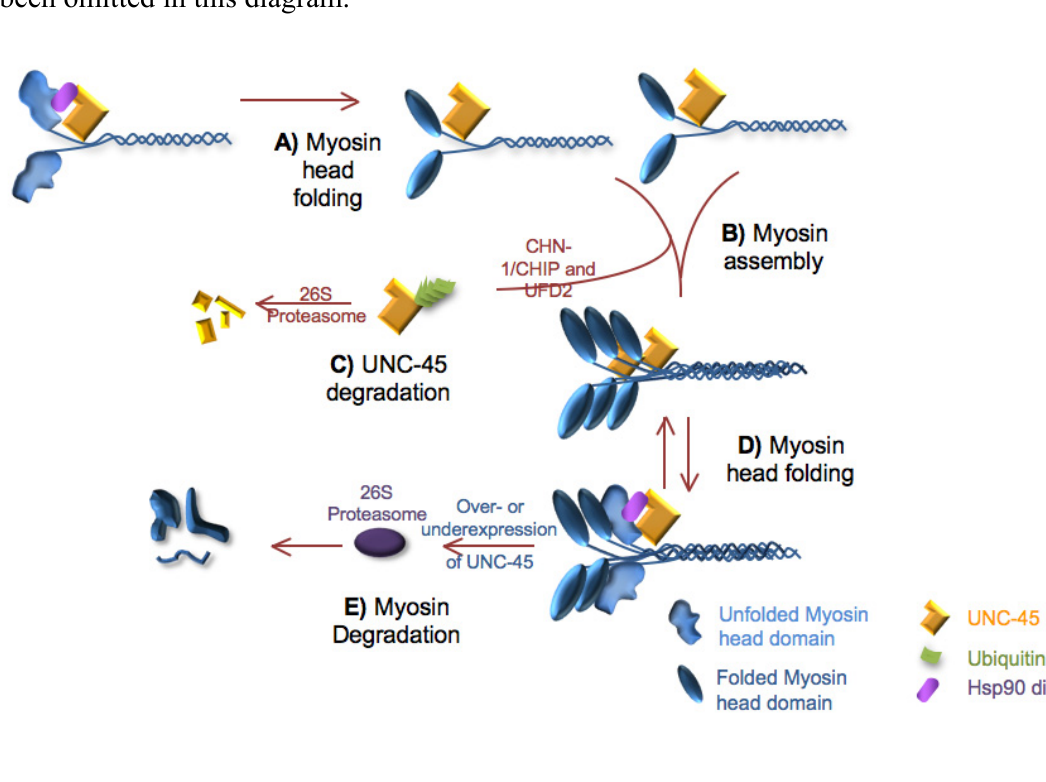
Figure 3. Roles for UNC-45. A) UNC-45 and the Hsp90 co-chaperone are responsible